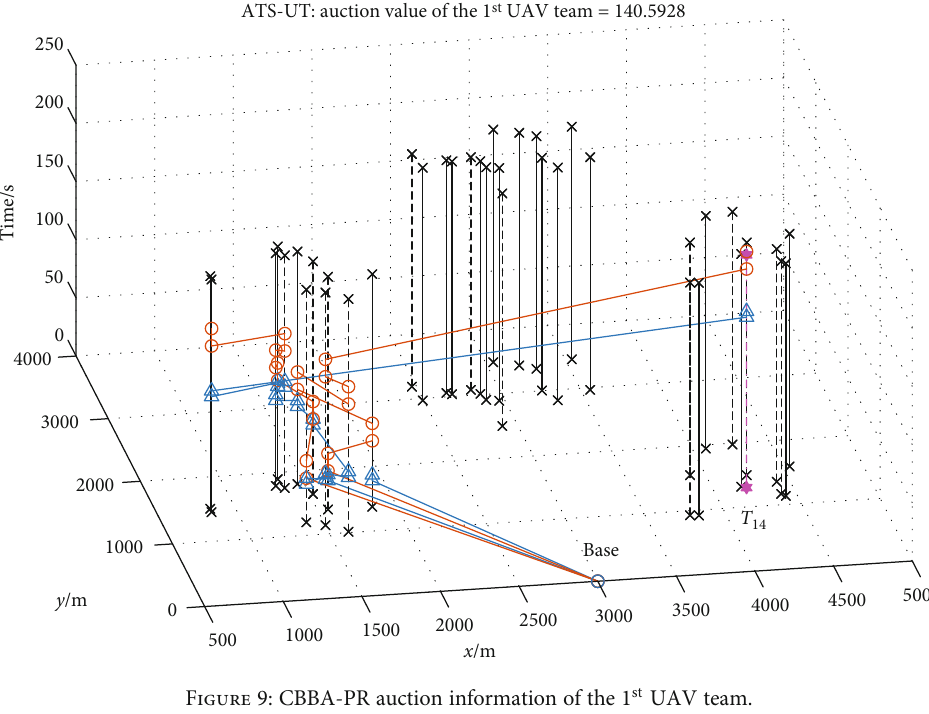
Figure 9: CBBA-PR auction information of the 1 st UAV team.